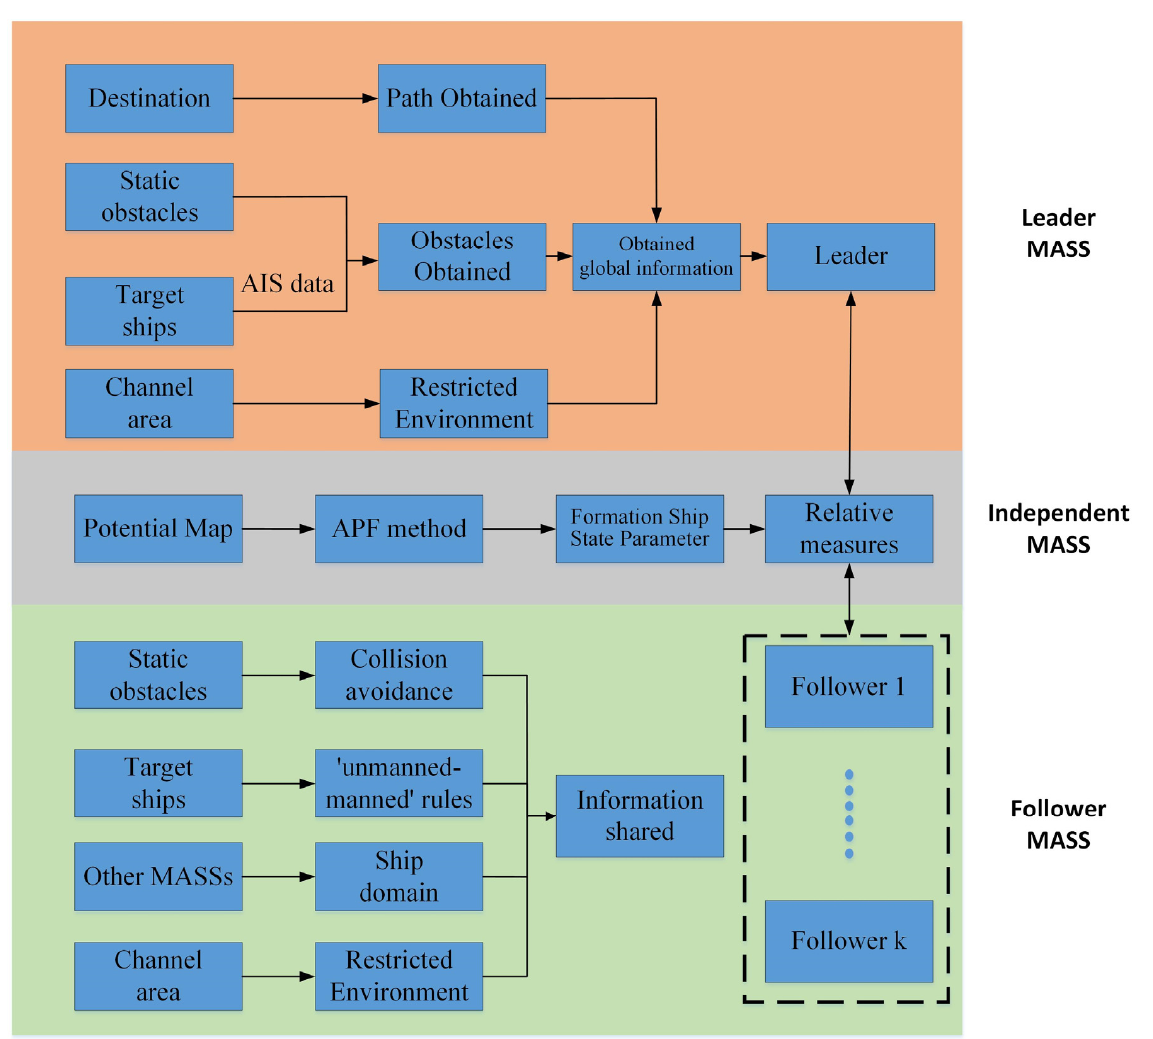
Figure 12. Formation information framework.